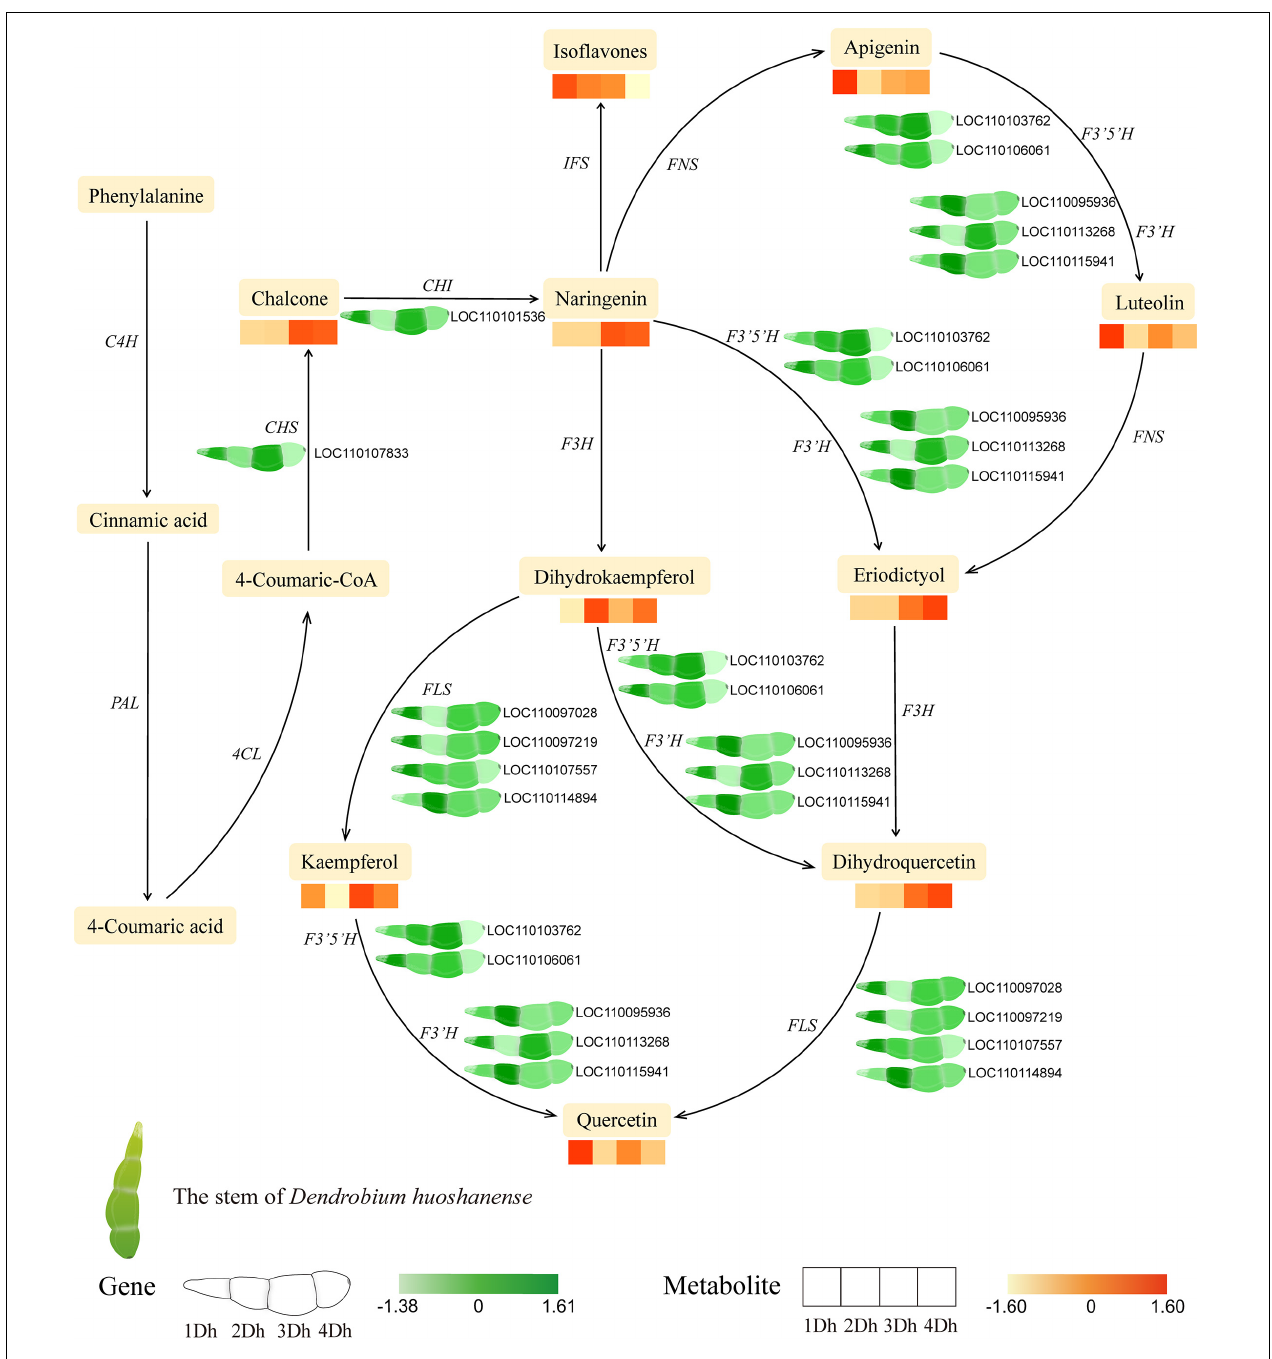
FIGURE 6 | The pathway associated with flavonoid biosynthesis in D. huoshanense . The expression heatmap of the key metabolites and transcripts for flavonoid synthesis between four groups was shown by the colored cell on the bottom. Key enzyme gene abbreviation: PAL , phenylalanine ammonia lyase; 4CL , 4-coumarate: CoA ligase; C4H , cinnamate 4-hydroxylase; CHS , chalcone synthase; CHI , chalcone isomerase; F3H , flavonoid 3-hydroxylase; F3’H , flavonoid 3’-hydroxylase; F3’5’H , flavonoid 3’,5’-hydroxylase; FNS , flavone synthase; FLS , flavonol synthase; AOMT , flavonoid